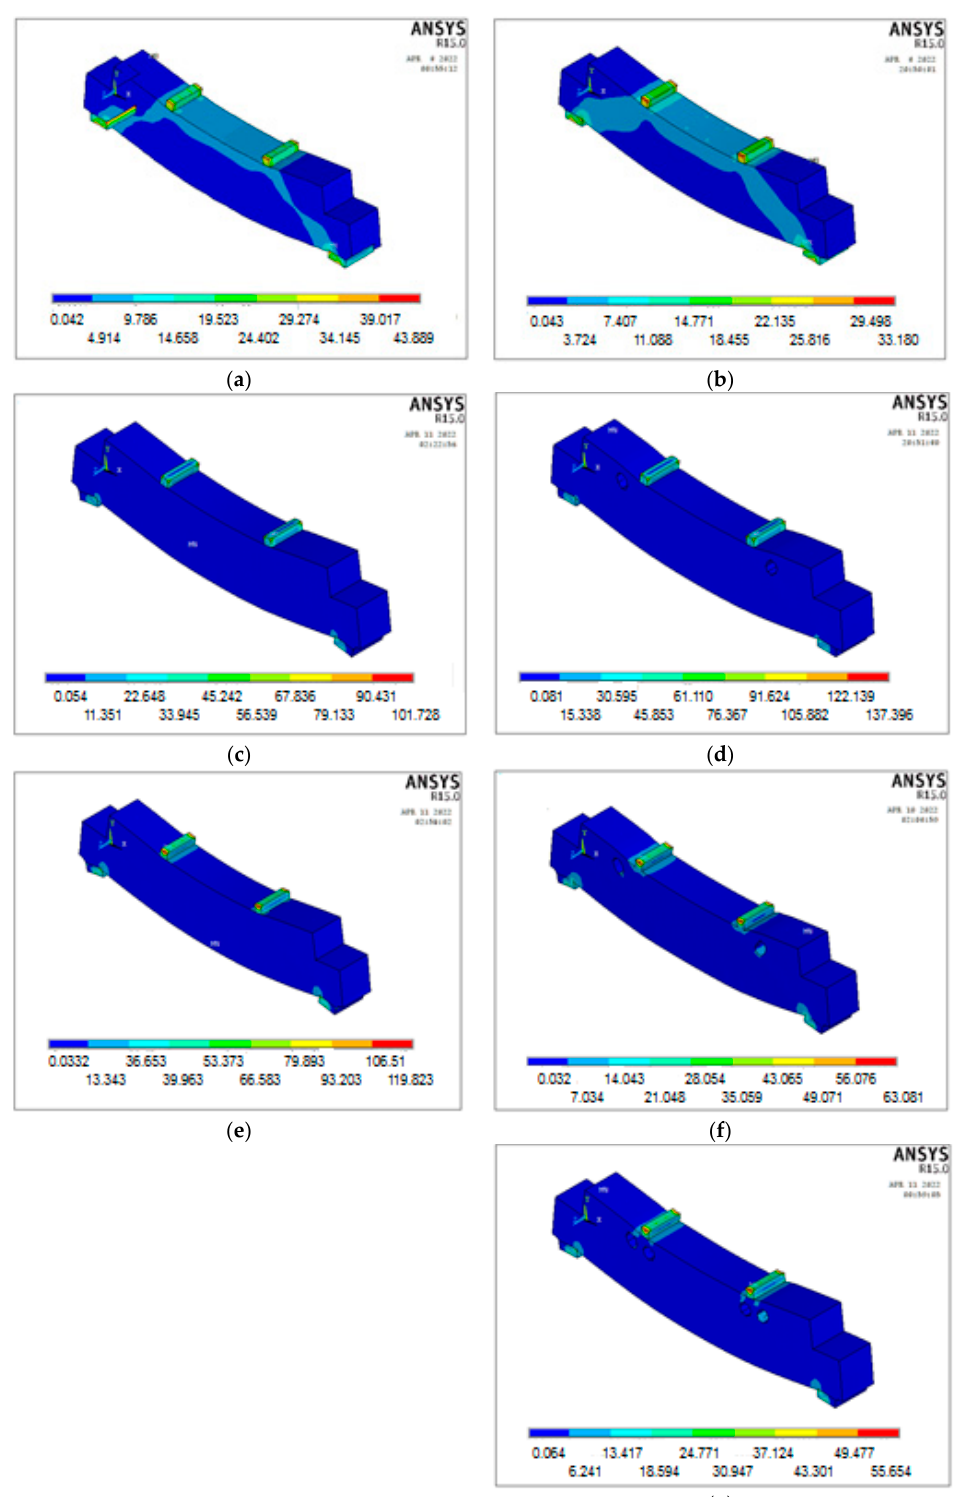
Figure 14. 3D contours of von Mises stress for all models. ( a ) DENT1. ( b ) DENT2. ( c ) DET3. ( d ) DET4. ( e ) DET5. ( f ) DET6. ( g ) DET7. ( e ) DET5. ( f ) DET6. ( g )